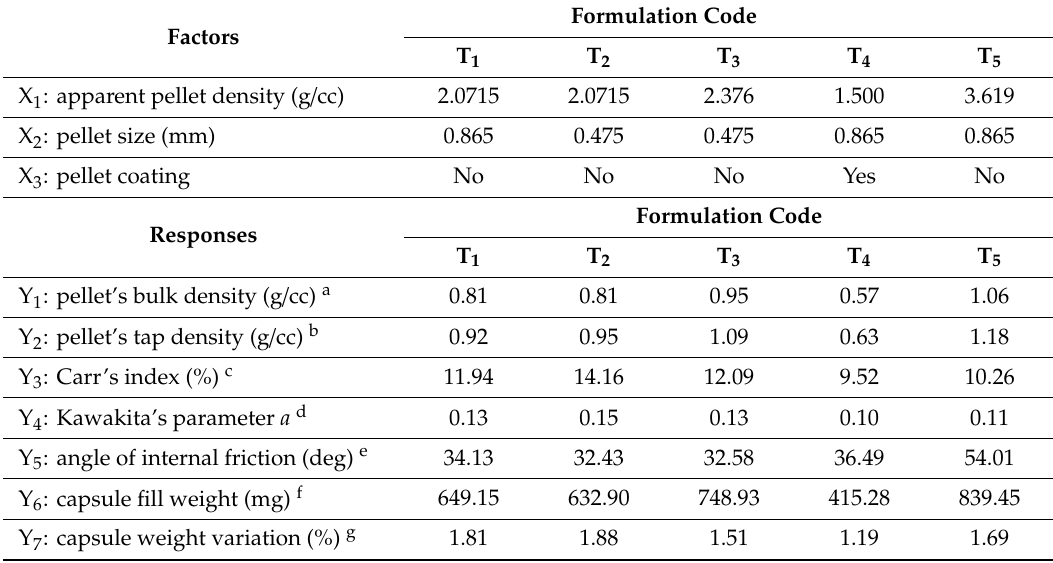
Table 2. External validation set used for the comparison of multiple linear regression (MLR) and artificial neural networks (ANN) models prediction